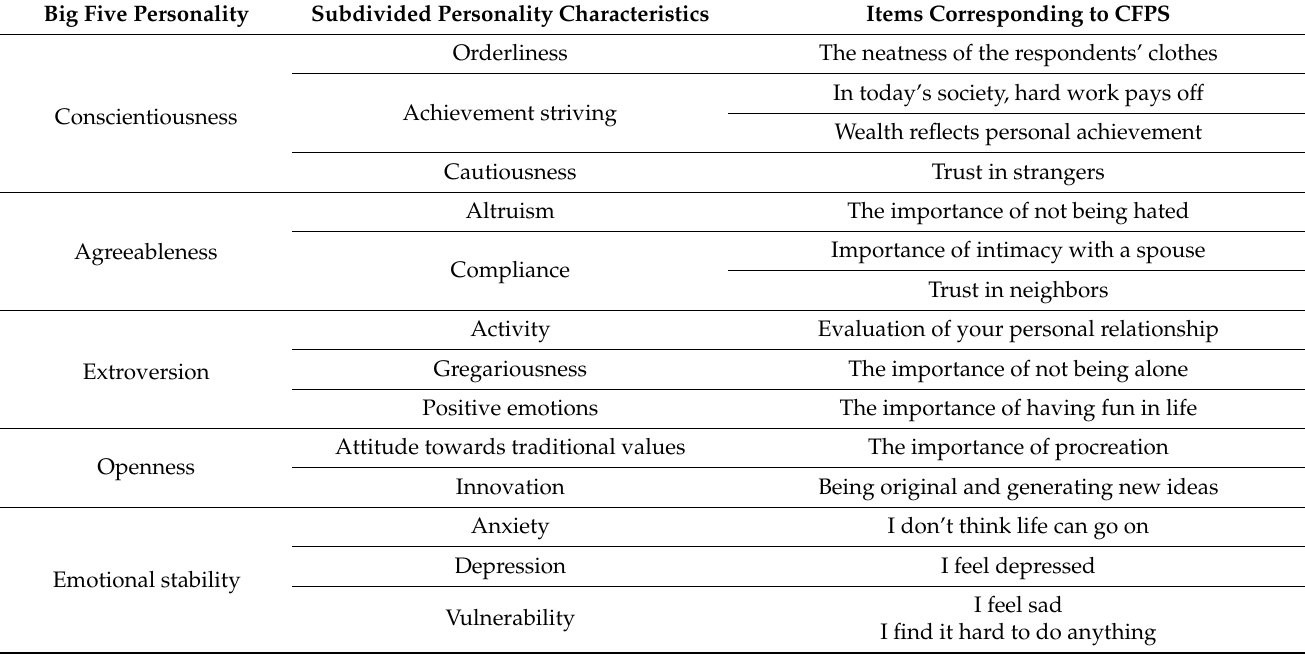
Table 1. Items corresponding to “Big Five personality” in